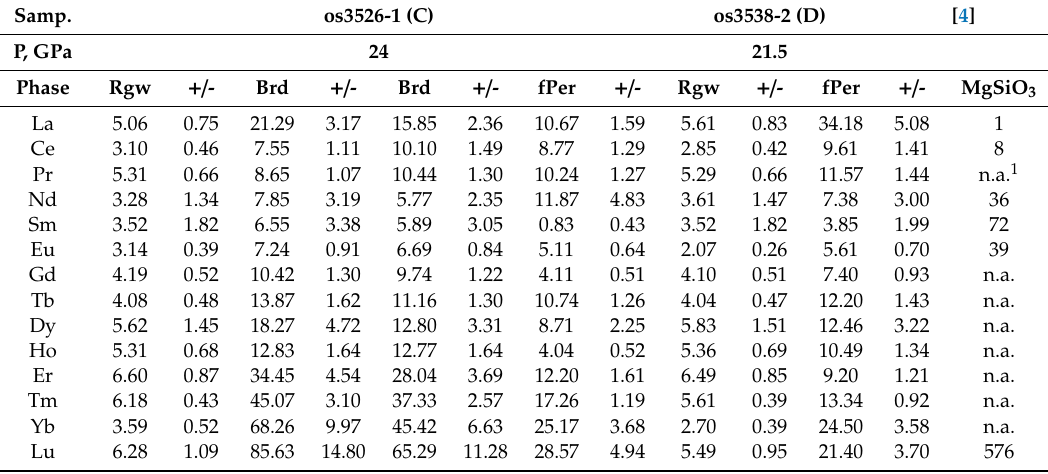
Table 3. Concentrations and measurement errors of trace elements in synthetic phases (La-ICP-MS analyses) as compared with experimental data [4] and the temperature for all samples is 1600 ◦ C. Samp.